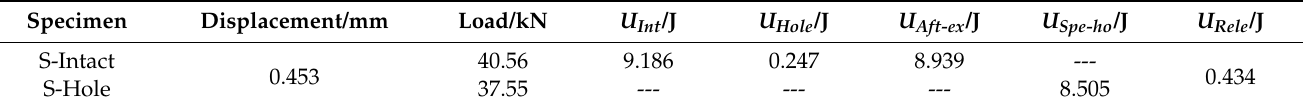
Figure 7. Load versus displacement curve of two models.